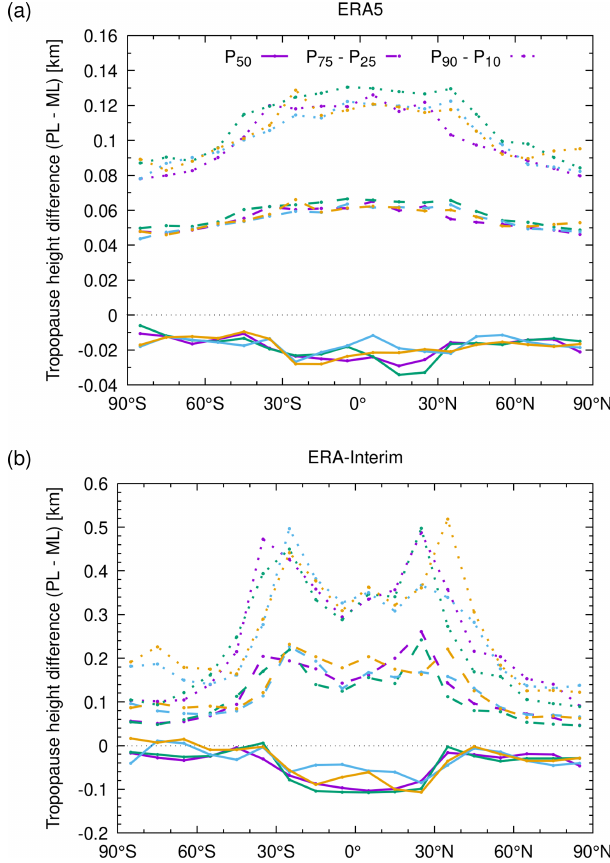
Figure A2. Zonal differences of tropopause geopotential heights derived from model level (ML) and pressure level (PL) data for (a) ERA5 and (b) ERA-Interim. Different curves show the median ( P 50 ), the interquartile range ( P 75 – P 25 ), and the difference of the P 90 and P 10 percentiles of the differences. Colors refer to differ- ent days (purple: 1 January 2017, green: 1 April 2017, blue: 1 July 2017, orange: 1 October 2017). Data are shown for 00:00UTC each day.